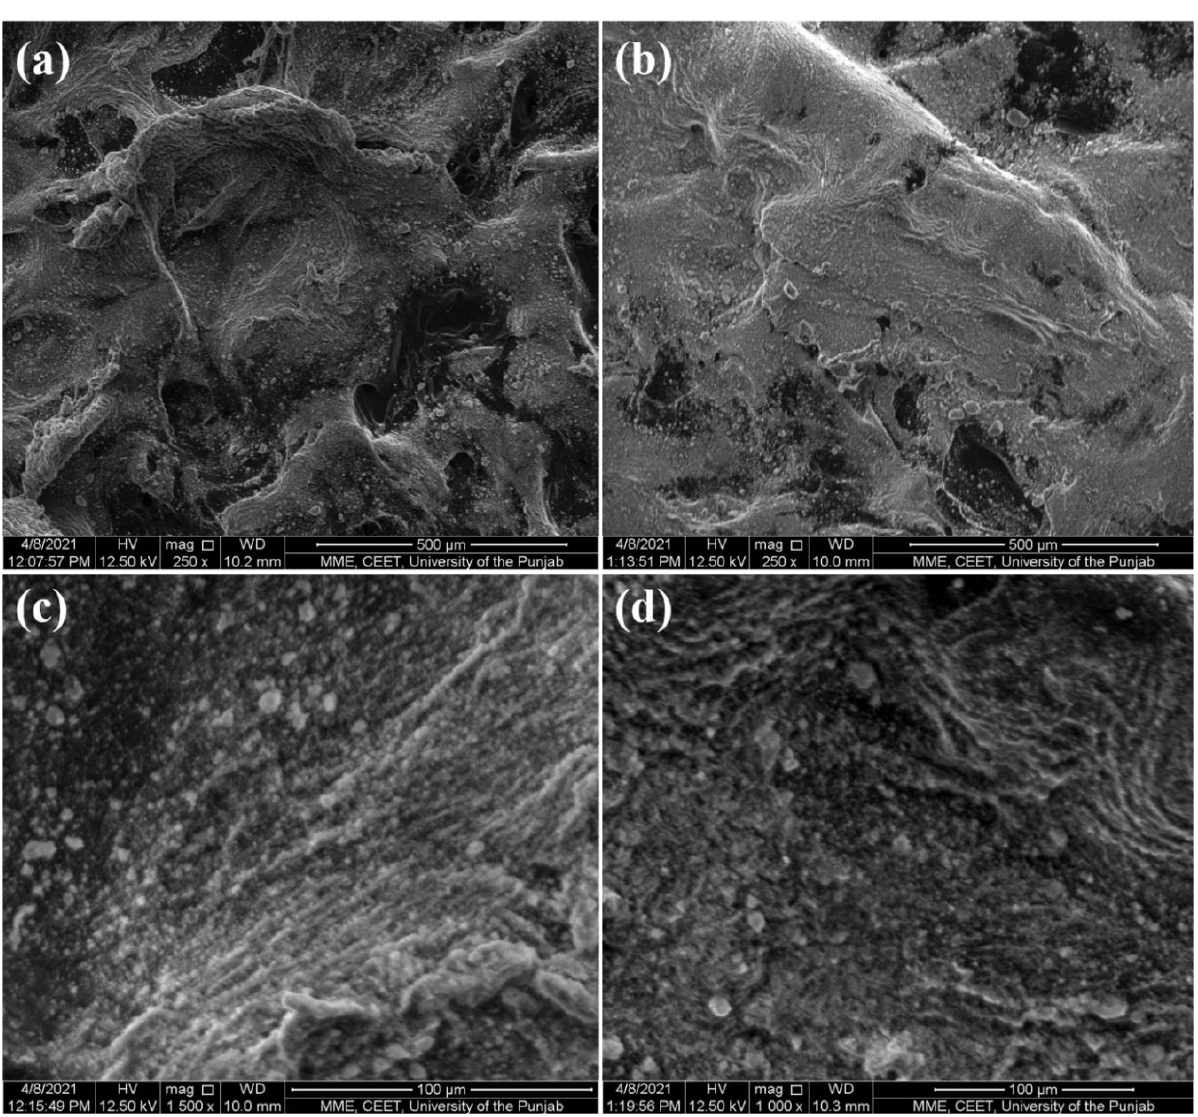
Figure 1. ( a , b ) XRD and ( c , d ) FTIR spectra of Bi@PMOS, Ce@PMOS, Bi 2 O 3 and CeO 2.